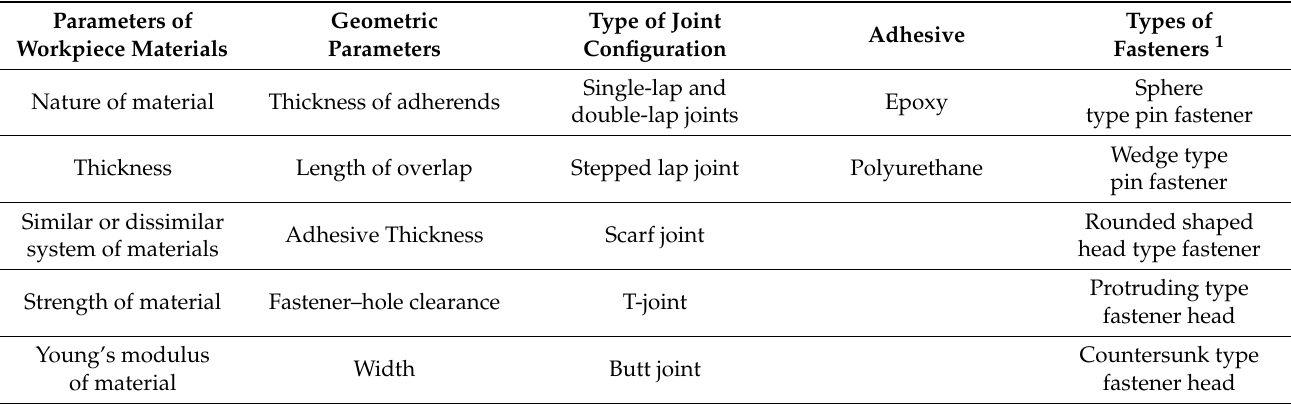
Table 1. Process parameters of hybrid bonded fastened joints [24,26].